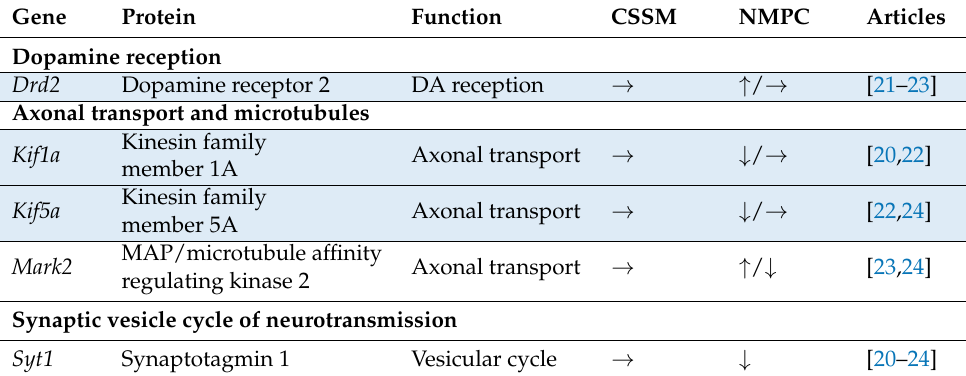
Table 3. Comparison of changes in neuronal protein gene expression in the substantia nigra of mice in our clinical stage model of Parkinson’s disease (CSSM) and in neuromelanin-containing neurons isolated from the substantia nigra of patients with Parkinson’s disease